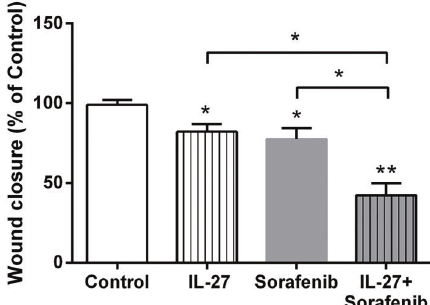
Figure 4. Effect of IL-27 (50 ng/mL) and sorafenib (2 m M) alone or their combination on wound closure of HTB-9 cells, measured by the scratch assay. Cells cultured with blank medium acted as control. Data are reported as the mean ± SE of 3 independent